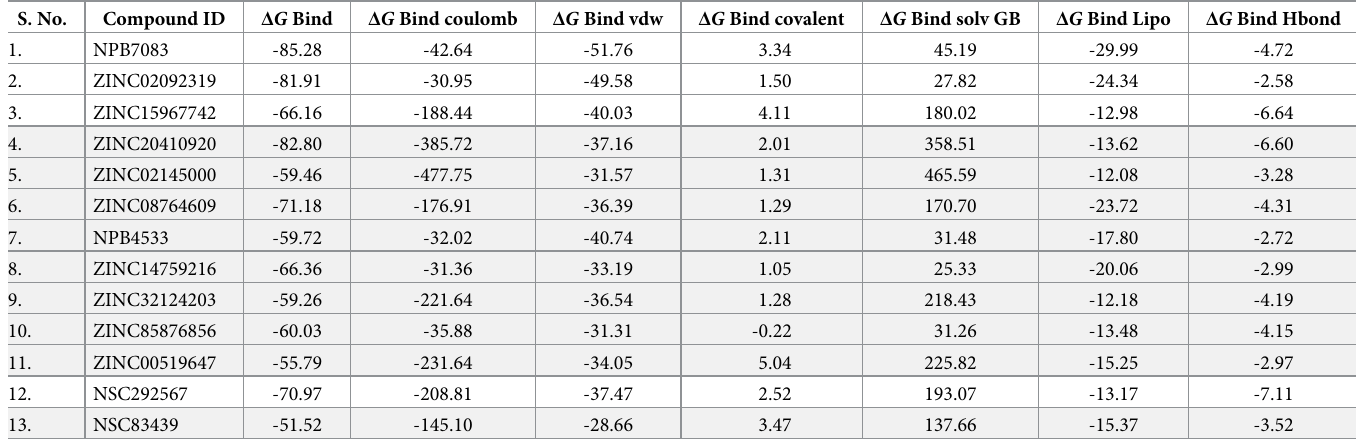
Table 4. Calculated binding free energies (Kcal/Mol) of the screened compounds.